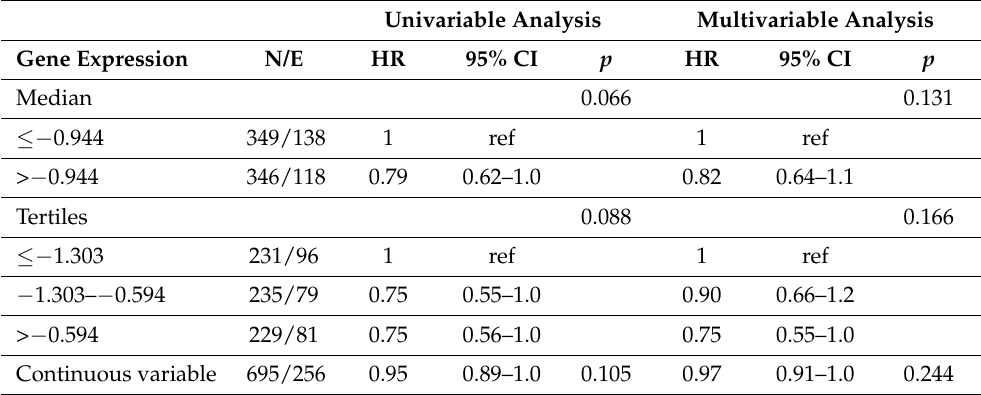
Table 20. Event Free Survival of 695 NB patients in relation to NTSR2 expression levels evaluated by the Cox regression